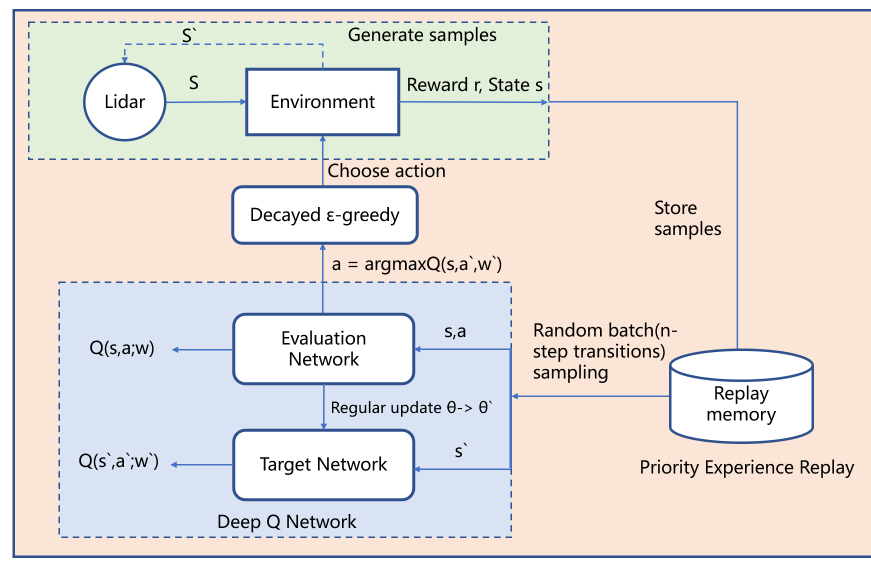
Figure 3. The model of the RND3QN